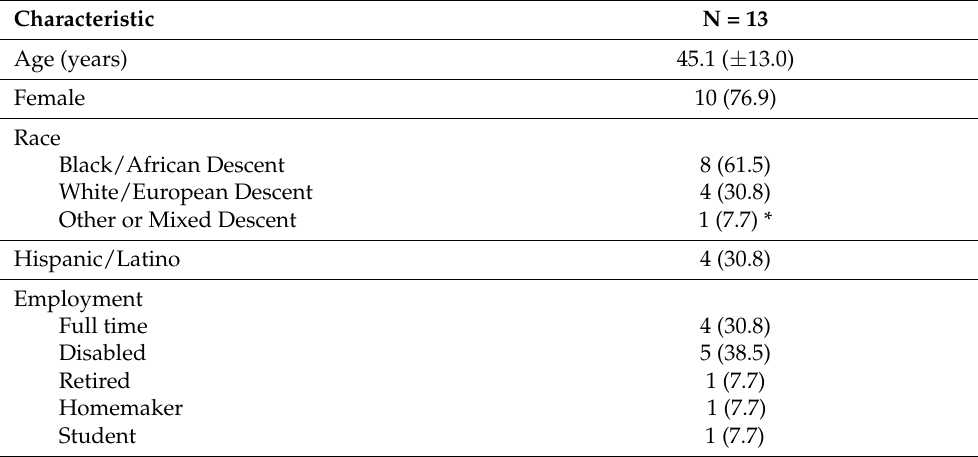
Table 1. Patient Demographics and Socioeconomic